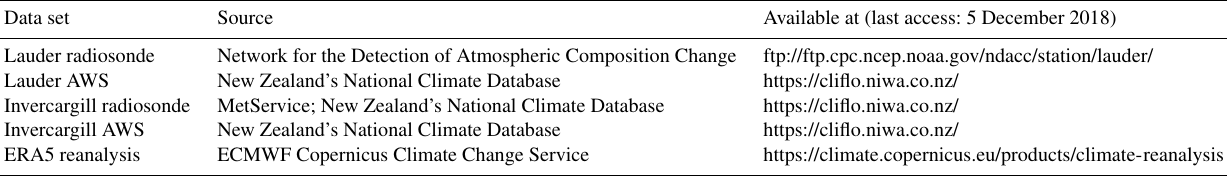
Table 1. The data sets used. For those data sets available in New Zealand’s National Climate Database, Table 2 gives the agent number and network number which are required to identify the site. The Invercargill radiosonde measurements are obtained from two sources, (i) New Zealand’s Climate Database (low resolution), and (ii) as high-resolution profiles in the original Vaisala output format (MetService). The high resolution Vaisala files, which also include a range of metadata, have been processed into netCDF files (Bruno Kinoshita, personal communication, 2017) and are used for the years they are available. AWS abbreviates automatic weather station.